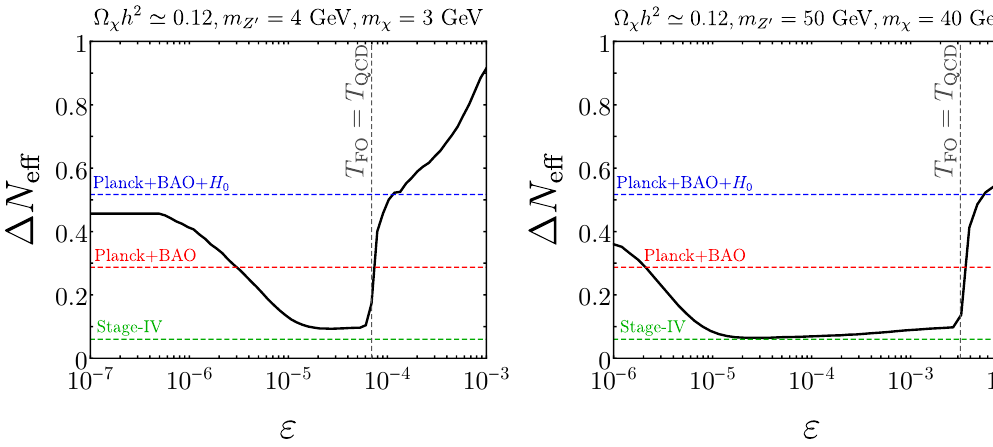
Figure 3 . Expected contribution to (cid:1) N e(cid:11) in our model for given parameters that allows to achieve the correct DM relic density. Constraints from the Planck collaboration including BAO is shown in dashed red, constraints taking into account the Hubble tension is shown in dashed blue and sensitivity prospects for the next generation of CMB experiments in shown in dashed green. Details regarding these constraints are detailed in section